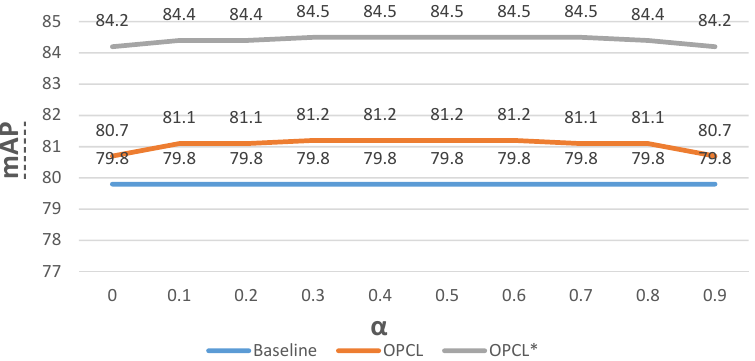
Figure 9. The searching process about control factor α on OPCL. The symbol “*” means the gradient of OPCL with respect to IoU is computed during